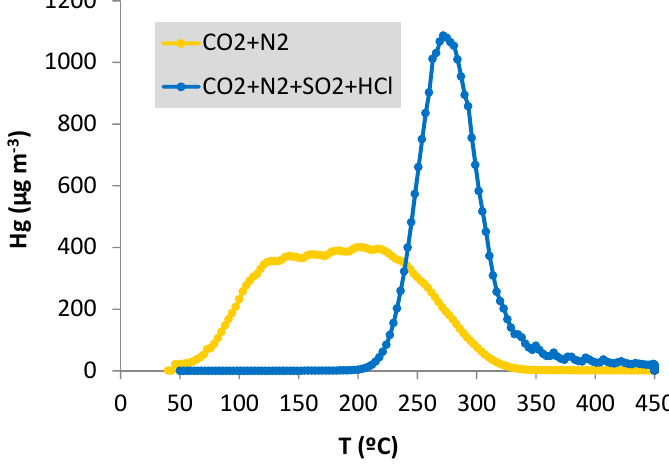
Figure 7. Mercury desorption profiles during the regeneration of CF-Au in different atmospheres.